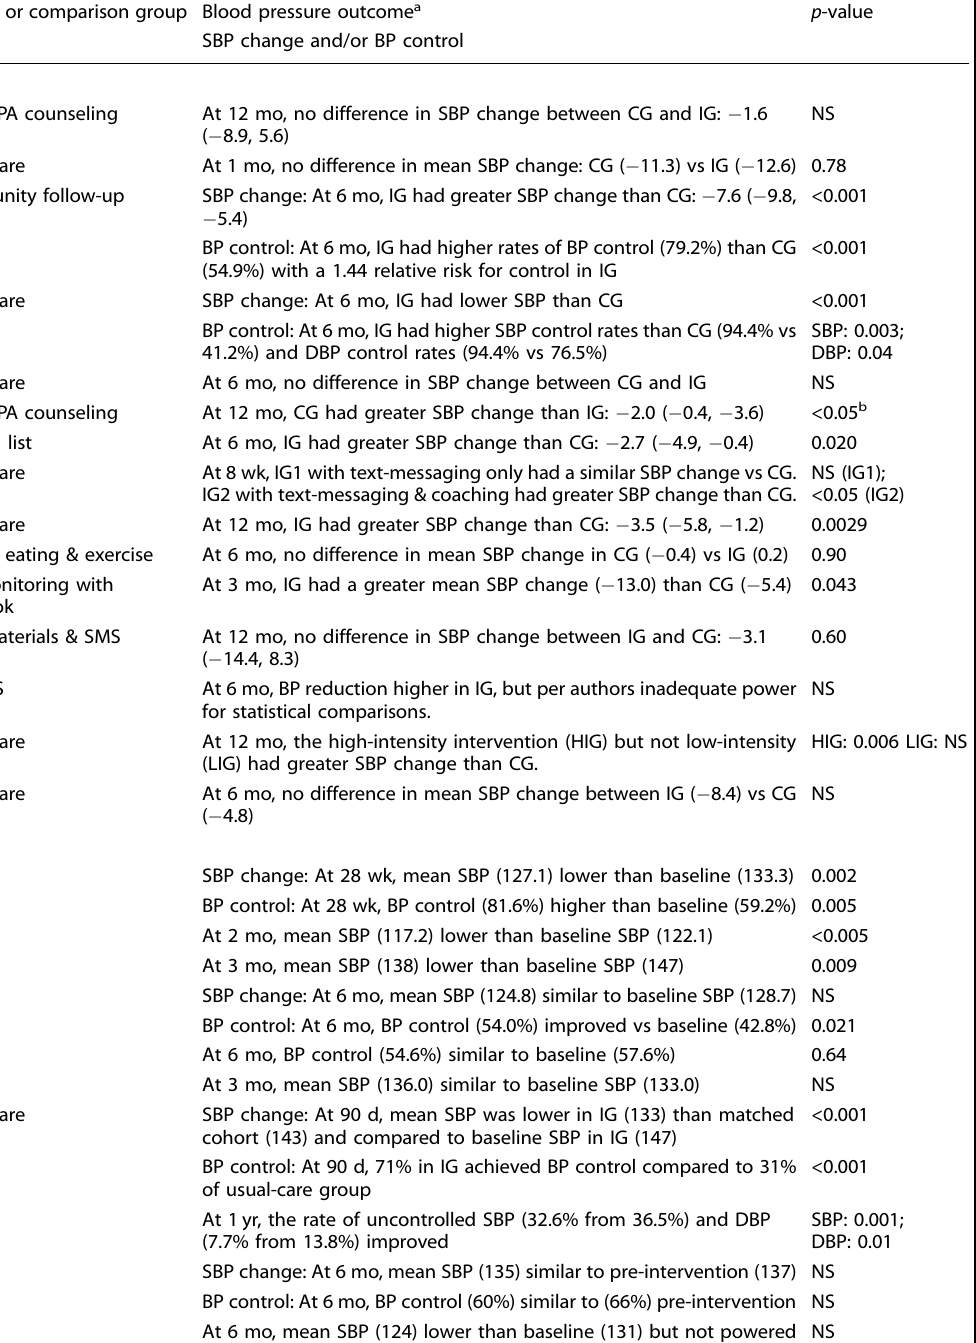
Table 3. Blood Pressure Outcomes. Study Control or comparison group Blood pressure outcome a p -value Randomized clinical